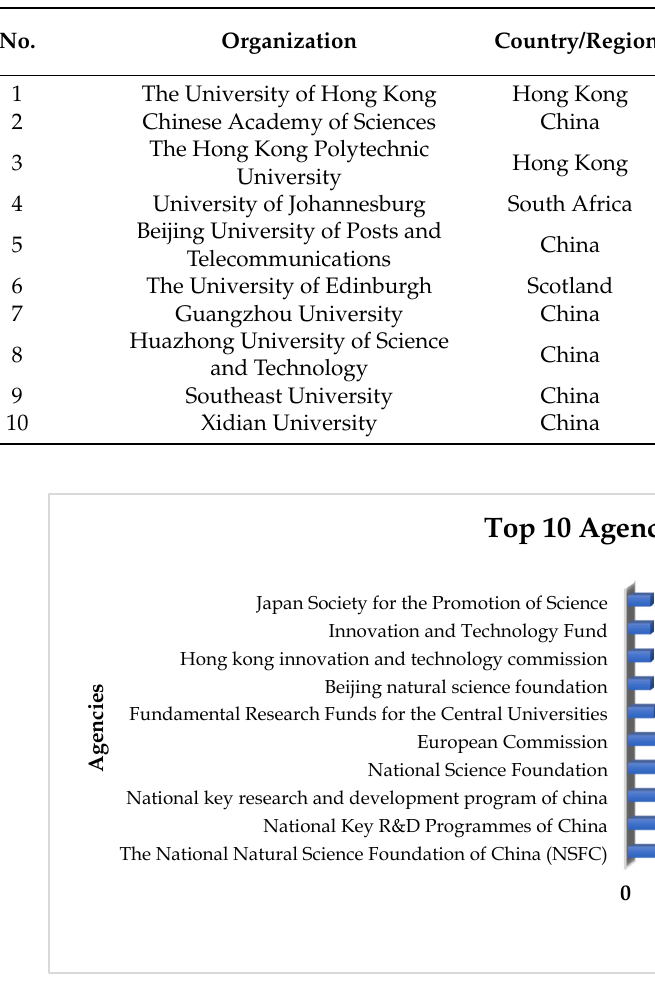
Figure 10. Top influential funding agencies.